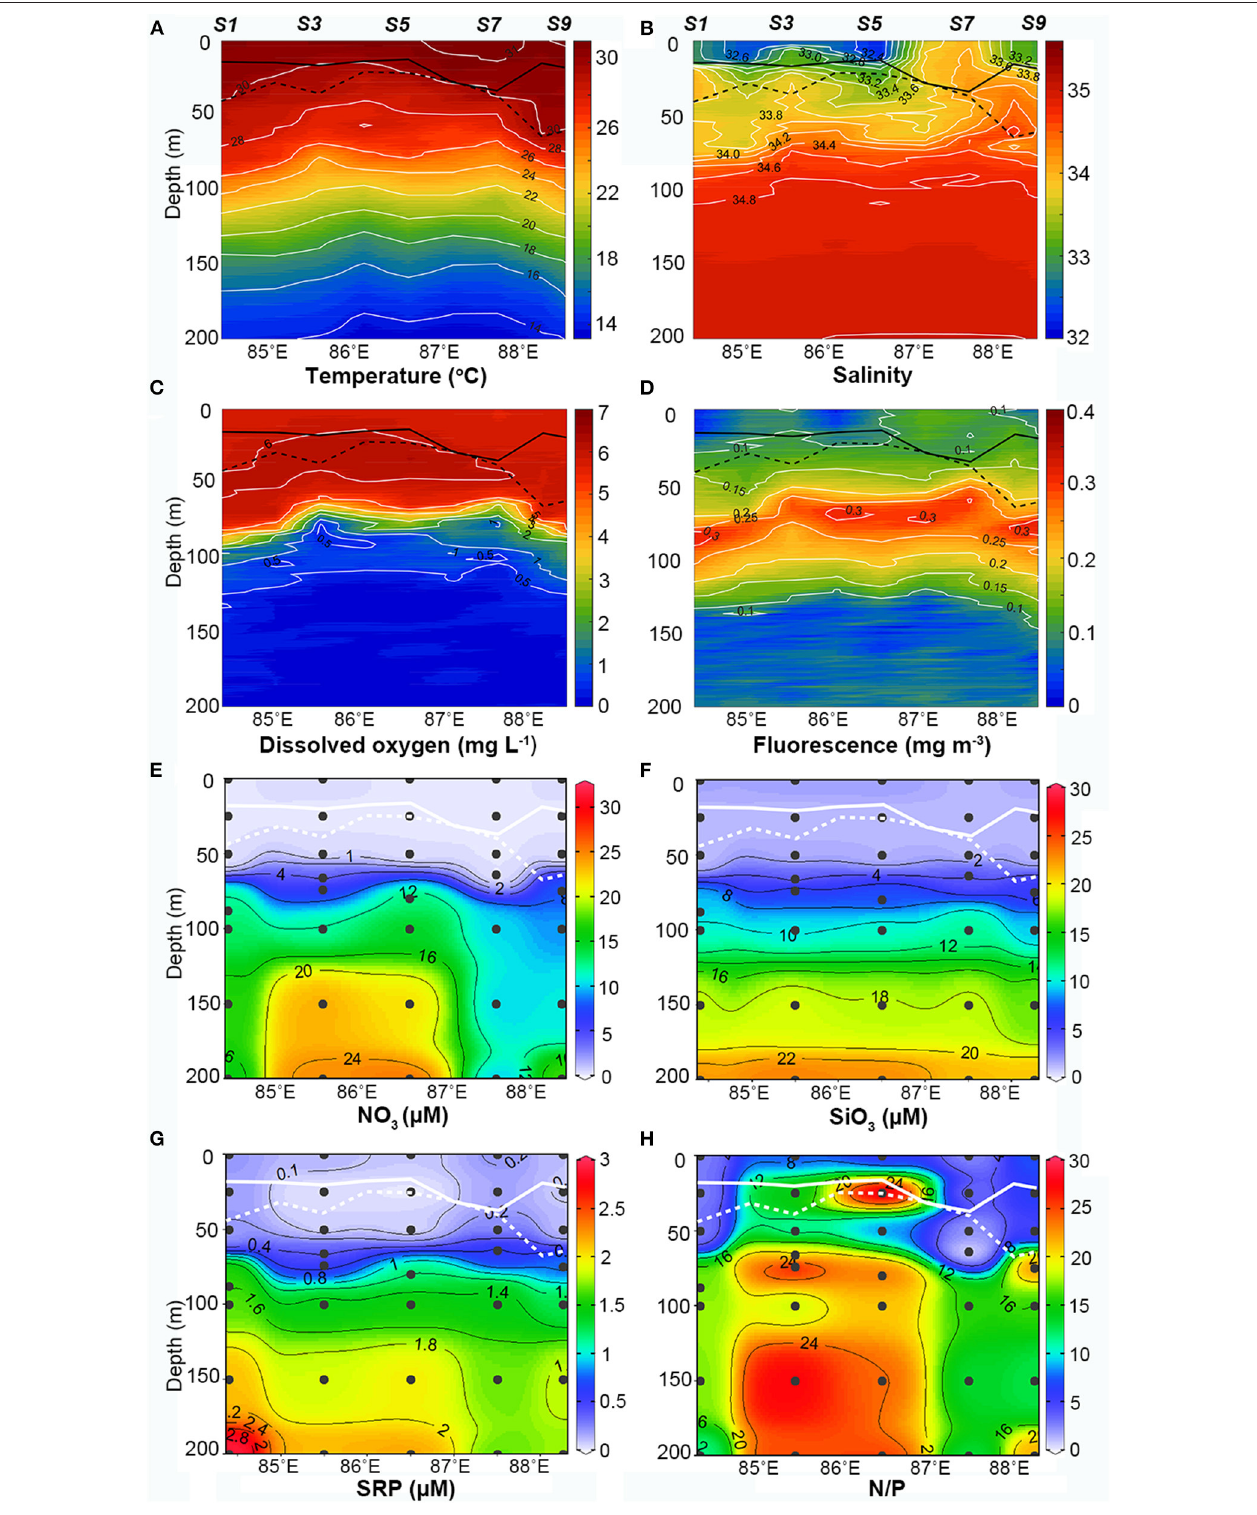
FIGURE 2 | Vertical profiles of in situ (A) temperature ( ◦ C), (B) salinity, (C) dissolved oxygen (mg L − 1 ), (D) fluorescence, (E) nitrate ( µ M), (F) silicate ( µ M), (G) dissolved reactive phosphorous ( µ M), and (H) ratio of nitrate to dissolved reactive phosphorus (N/P) to P along the section in the upper 200m. The solid and dashed lines plotted in each panel represent mixed layer depth and isothermal depth,